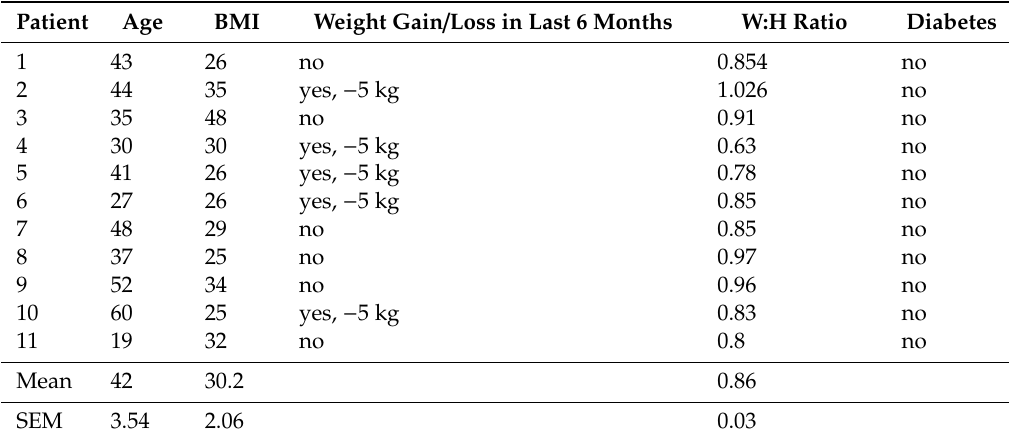
Table 1. In Table 1, the demographics (age, body-mass-index (BMI), waist / hip ration) and clinical history (weight gain / loss, diabetes) are shown for each